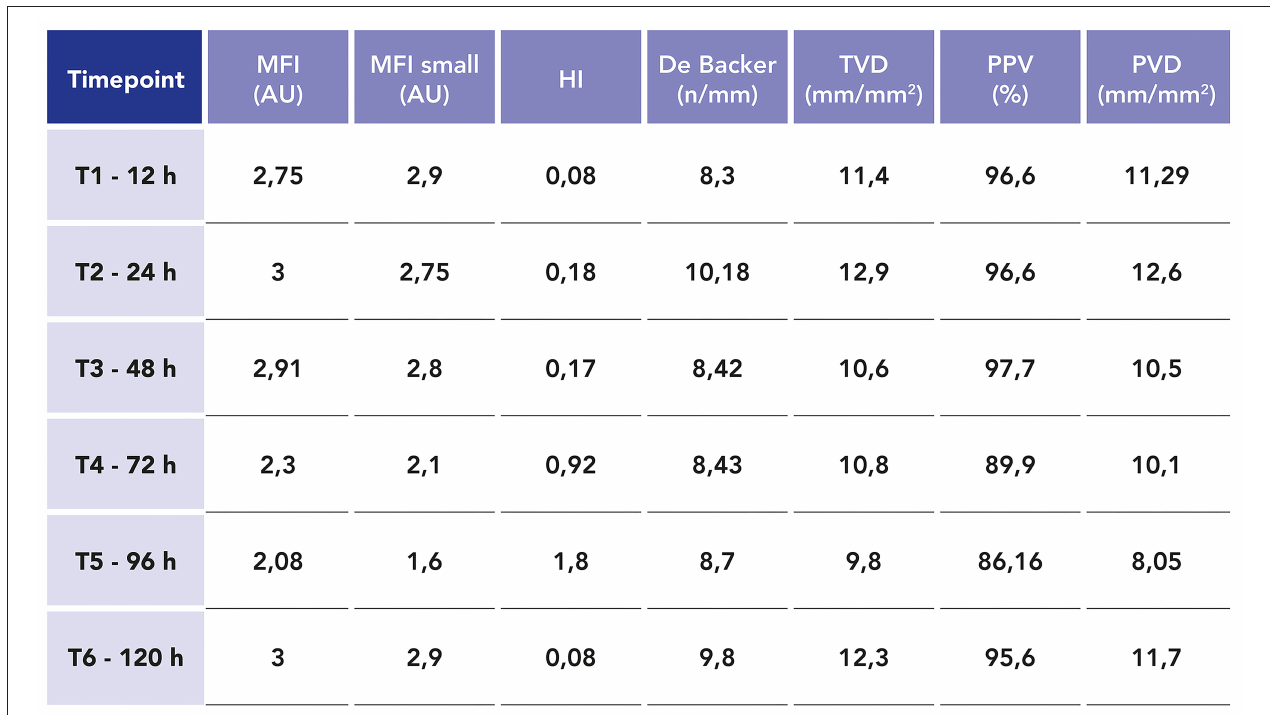
FIGURE 3 | Values of the most important microcirculation parameters related to microvascular flow and capillary density at different time points during extracorporeal blood purification treatment: microvascular flow index ( MFI ), mean flow index small vessels ( MFI small ), heterogeneity index ( HI ), De Backer score, total small vessel density ( TVD ), proportion of perfused vessels ( PPV ), and perfused microvascular density ( PVD